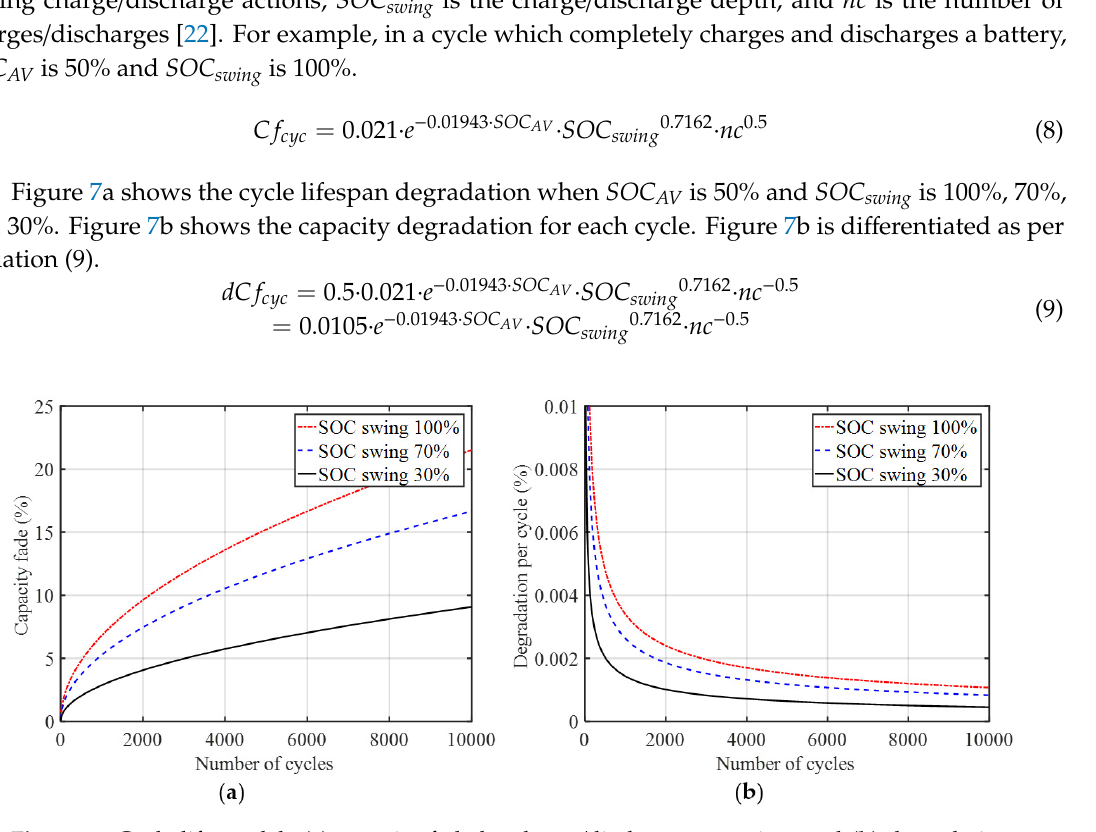
Figure 7. Cycle life model: ( a ) capacity fade by charge / discharge operation, and ( b ) degradation per